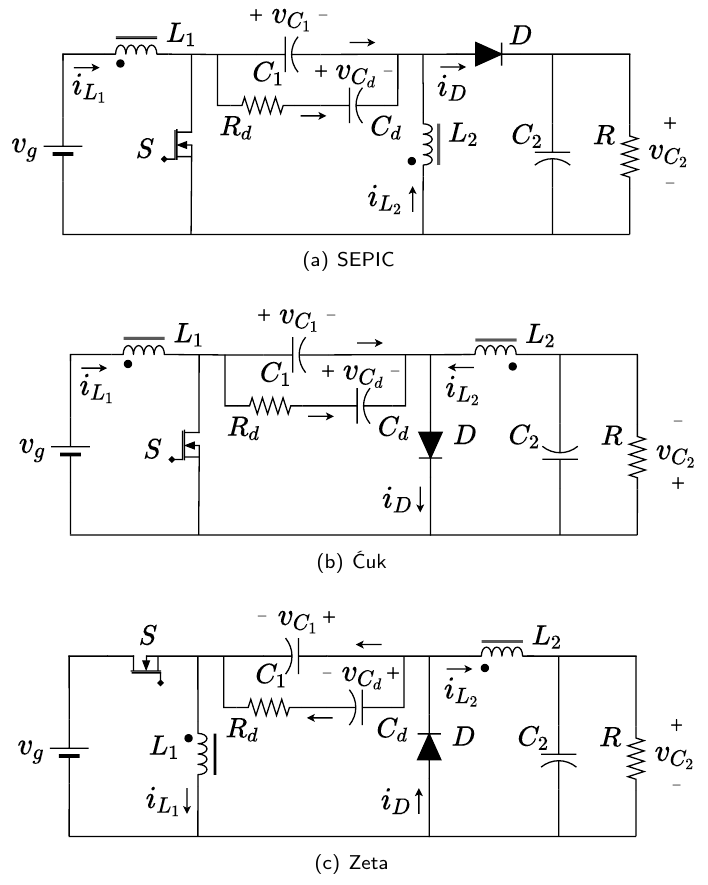
Figure 1. High-order converters: ( a ) SEPIC, ( b ) ´Cuk, ( c )